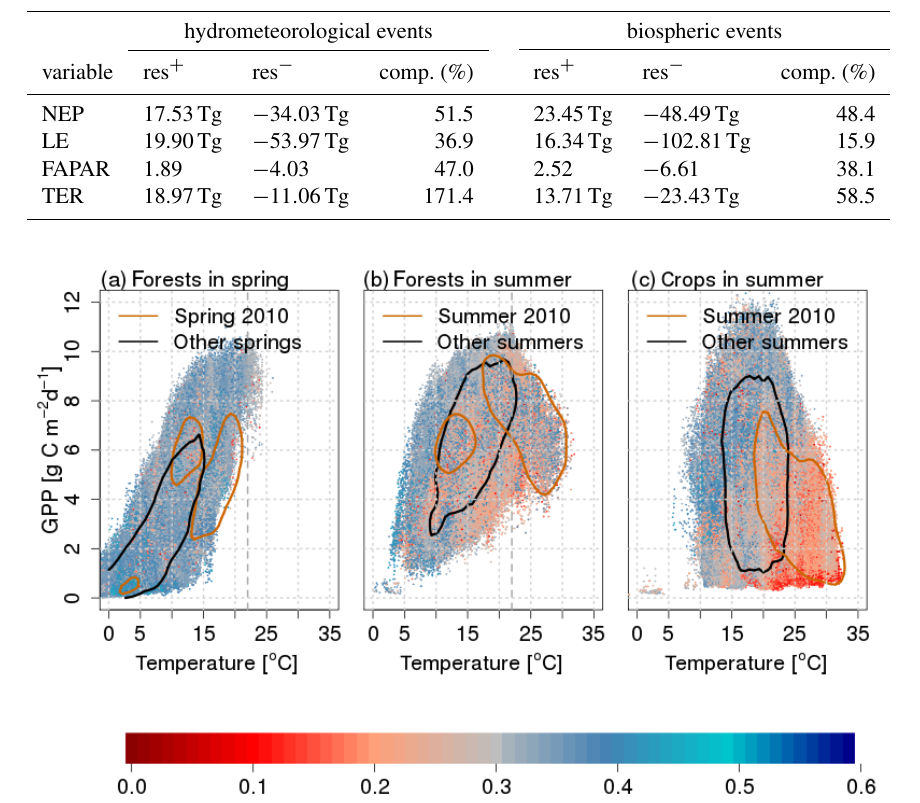
Table 2. Negative responses to the RHW are partly compensated based on the integrated biospheric or hydrometeorological events in 2010. The finding is consistent over different variables and data sets.